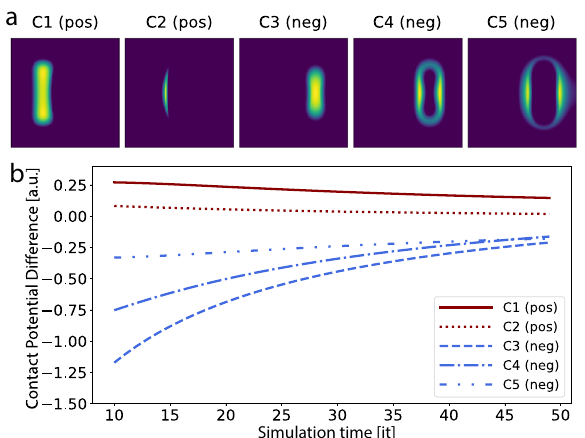
Fig. 5 Dictionary learning analysis of reaction – diffusion analysis. The maps shown in ( a ) and corresponding components shown in ( b ) demonstrate two speci fi c behaviours: positive and negative decays. The latter show a decreasing amplitude following a characteristic concentric structure, consistent with the presence of a diffusion